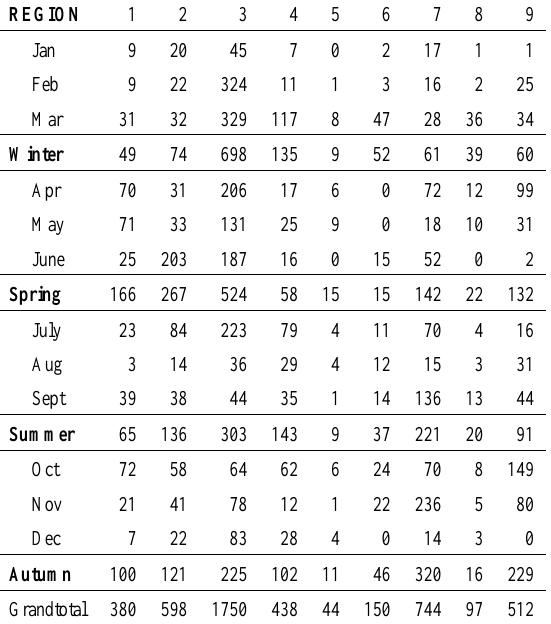
Table 2. Temporal breakdown by season and by region of the sim- ulated profiles whose minimum depth is 480m